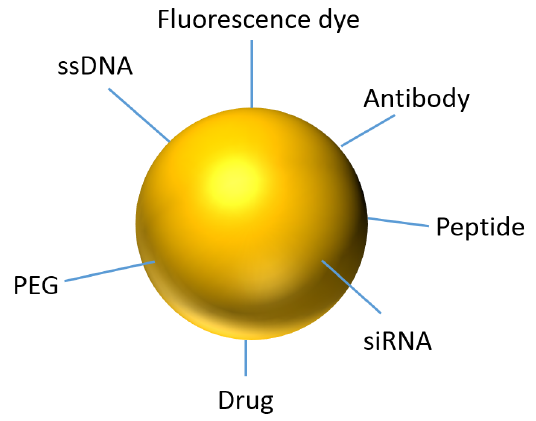
Figure 1. Representation of an Au NP for theranostics.